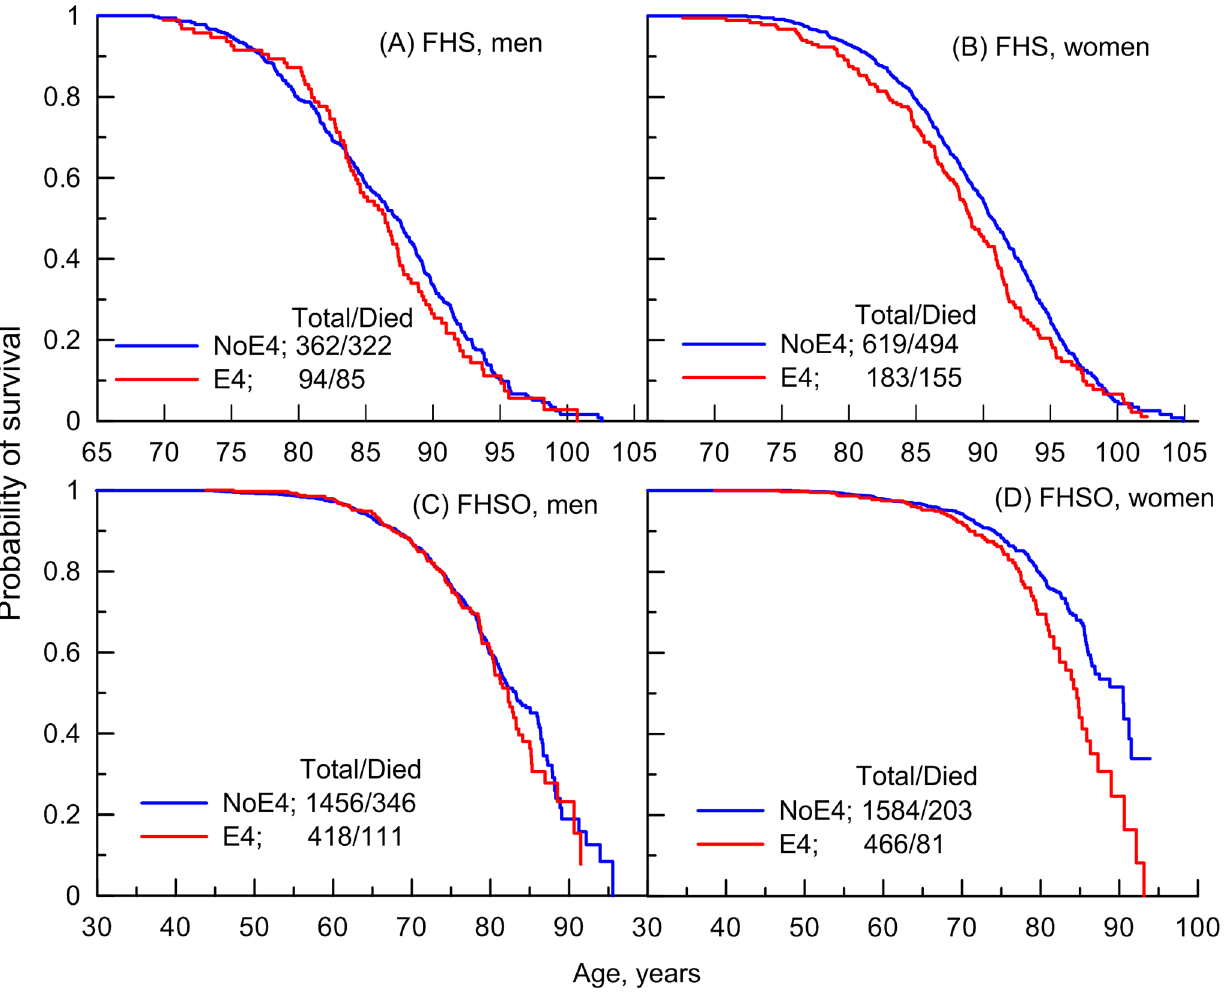
Figure 1. Empirical age patterns of survival of the ApoE4 carriers and non-carriers in the FHS. Patterns are shown for (A and C) men and (B and D) women genotyped in (A and B) FHS and (C and D) FHSO cohorts who carry (E4) and do not carry (NoE4) the ApoE4 allele. The numbers in the insets show the total number of genotyped individuals and the number of deaths among them.